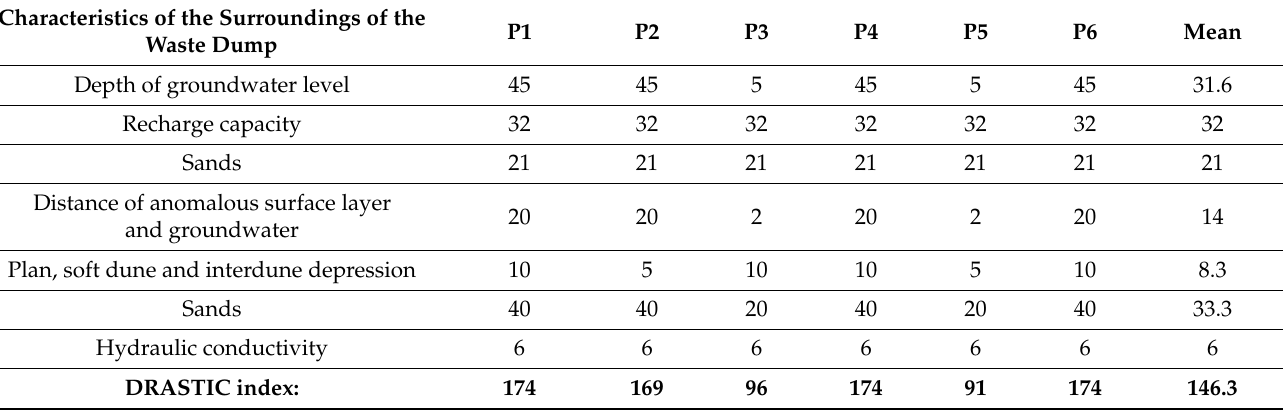
Table 2. Parameter values considered in the DRASTIC